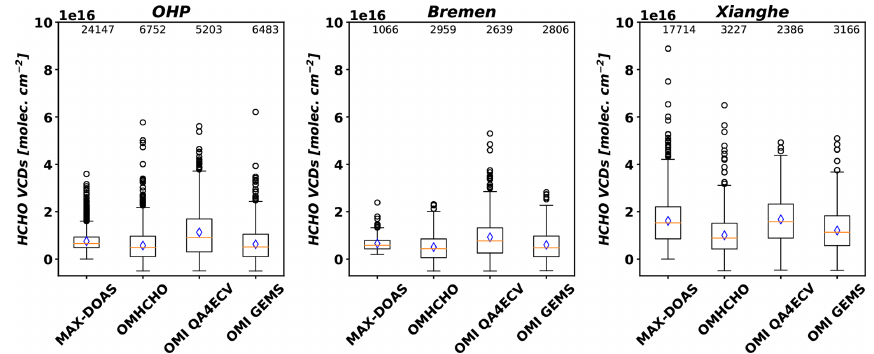
Figure 11. HCHO vertical columns from MAX-DOAS, OMHCHO, OMI QA4ECV, and OMI GEMS at OHP and Bremen in 2005 and at Xianghe in 2016. Orange lines are median values for each dataset, and blue diamonds are mean values. We computed mean values of each satellite product weighted by uncertainties and overlapped areas between satellite pixels and 0.25 ◦ grid cells for each site. Boundaries of boxes indicate the first and last quantiles of